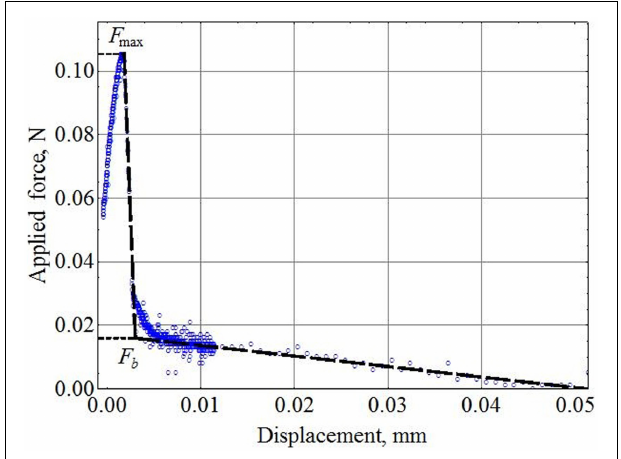
FIGURE 7 | Typical force–displacement curve for a RIM 135 resin-coated CNT fiber pulled out of epoxy matrix droplet